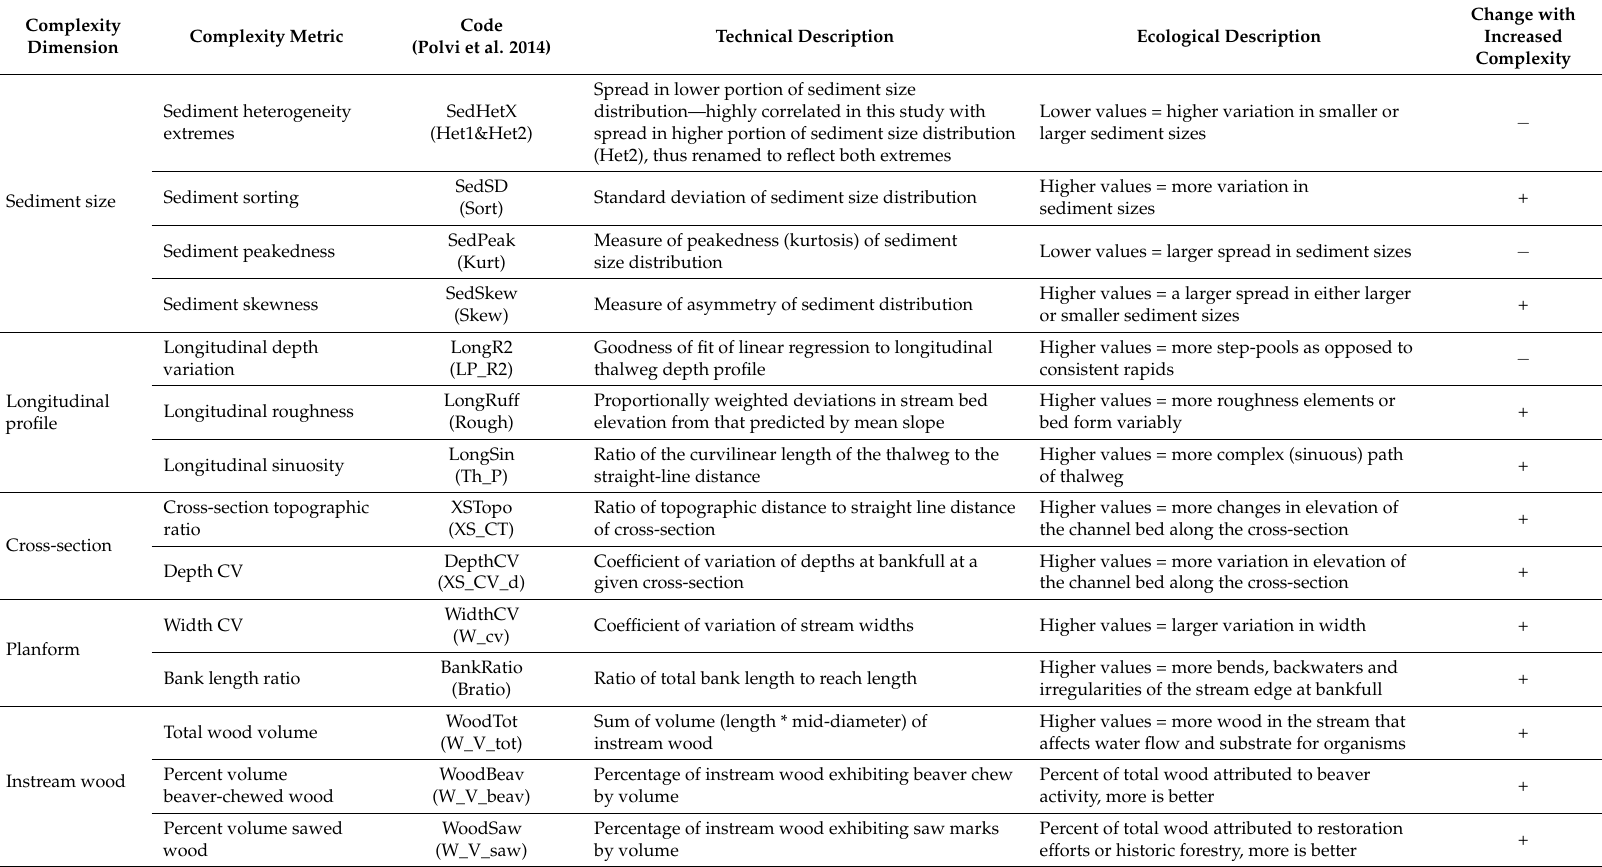
Table 1. Descriptions of the 14 geomorphic complexity metrics retained after tests of collinearity of the 29 original metrics in Polvi et al. [22]. Names of complexity metrics and their codes (abbreviations) were changed from the original paper to be more accessible to a wider audience. The original codes are shown in parentheses below our codes to enable comparison with